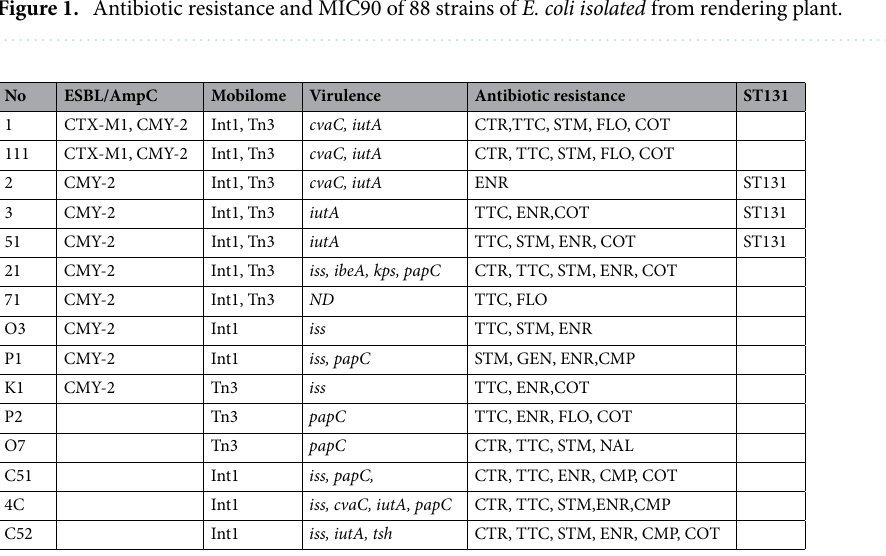
Table 1. Genotyping and antibiotic resistance in 15 selected E. coli isolated from rendering plant. iutA ferric aerobactin receptor; cvaC colicin V; kps capsular polysialic acid virulence factor; iss increased serum